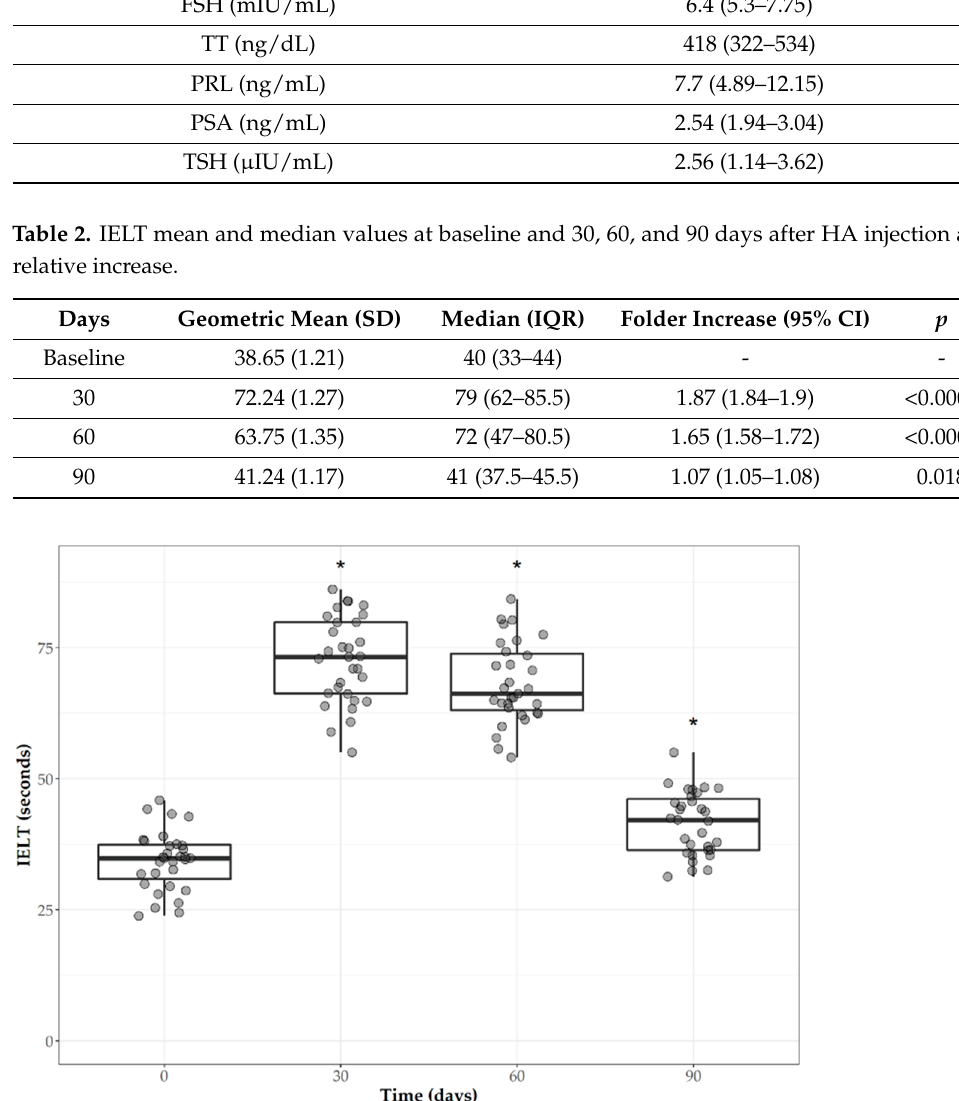
Figure 2. IELT before (0) and 30, 60, and 90 days after HA injection. * < 0.001 vs. baseline.